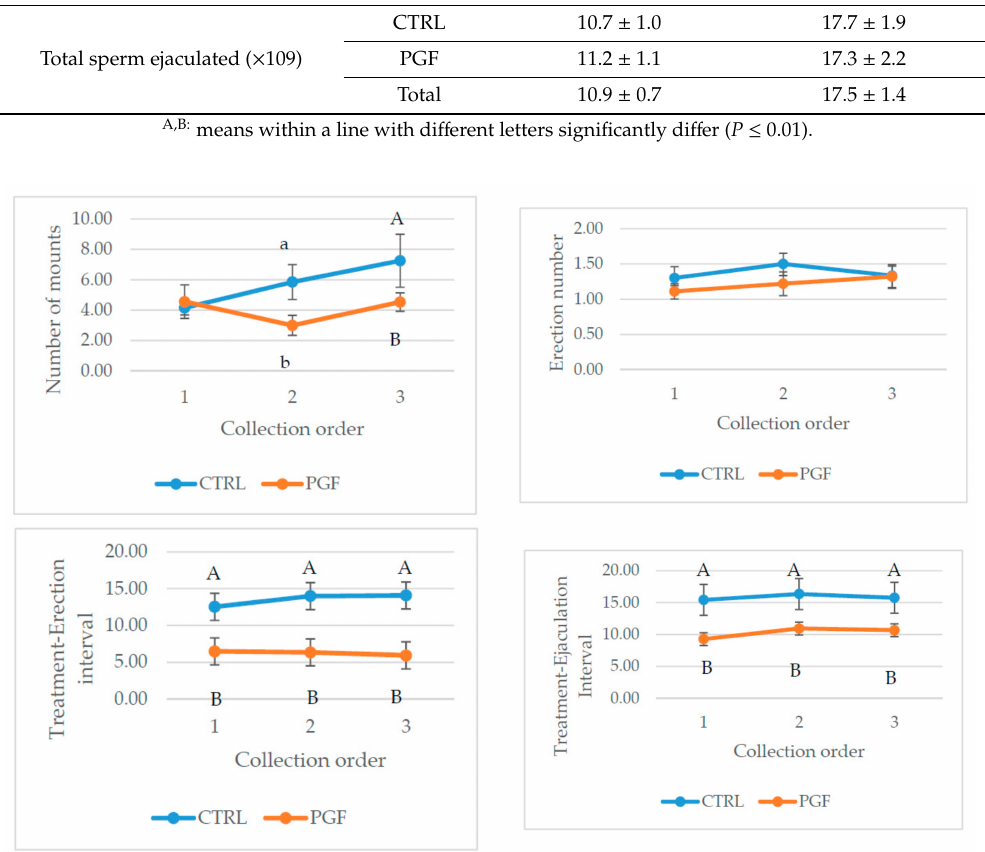
Figure 1. E ff ect of semen collection order (1, 2, or 3) and treatment (125 µ g of cloprostenol = PGF, or 1 mL of saline = Control) interaction for behavioral features of donkeys: Jumps on teaser jenny, number of erections, treatment-erection interval (minutes), treatment-ejaculation interval (minutes). Data are expressed as least squared mean ± standard error. a,b: means ± SEM within rows and columns within the same analyzed parameter, with di ff erent letters significantly di ff er ( P ≤ 0.05); A,B: means ± SEM within a column with di ff erent letters significantly di ff er ( P ≤